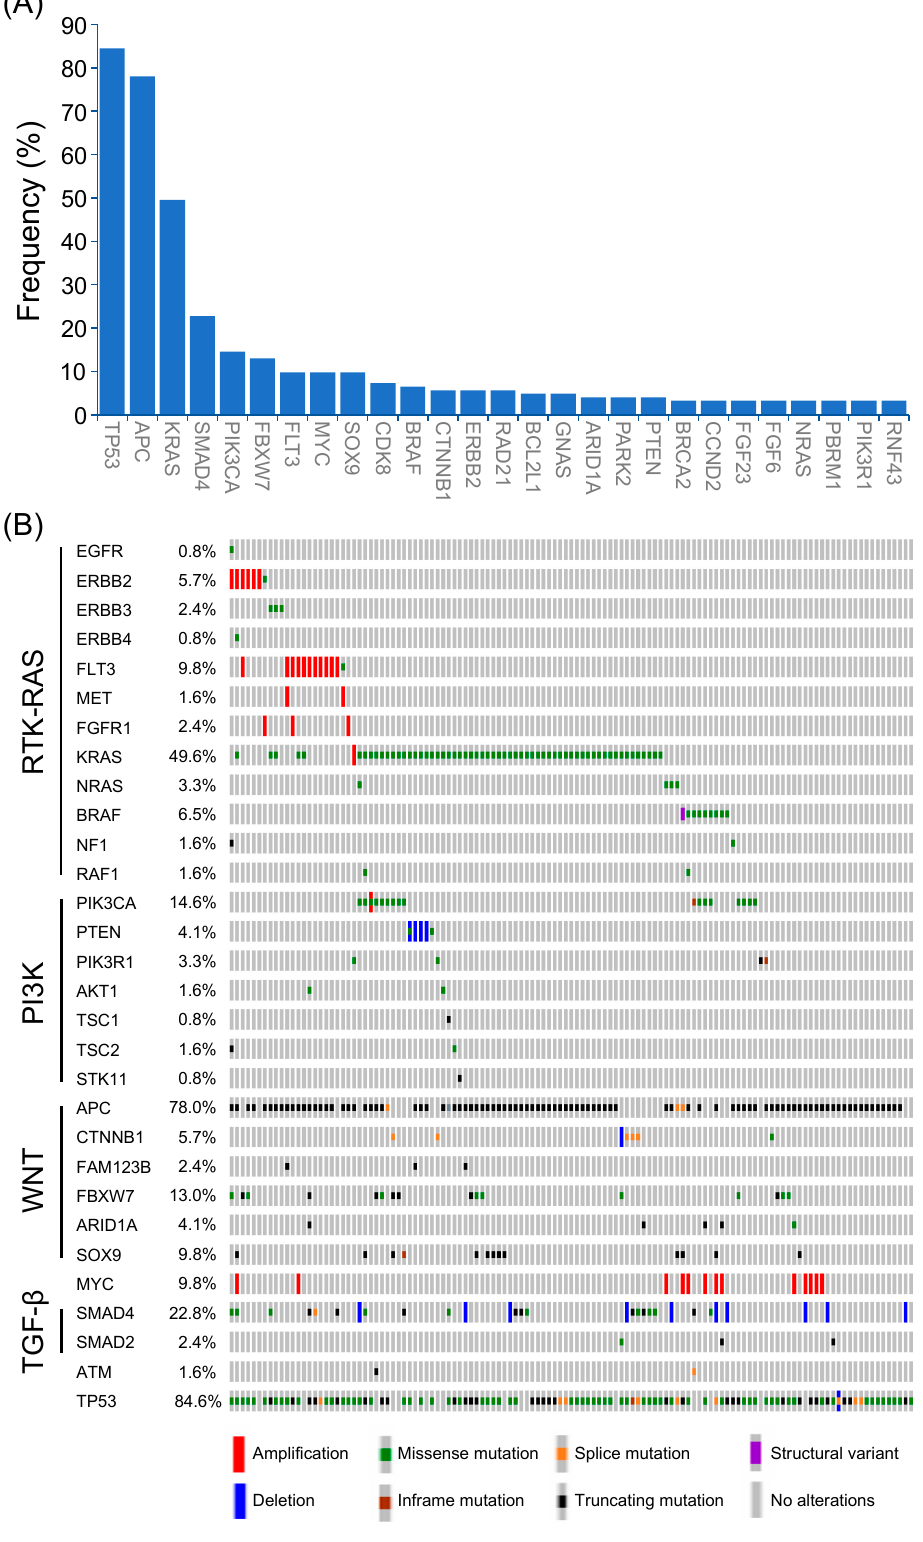
Figure 2. Genetic alterations of Taiwanese patients with non-MSI-H mCRC. ( A ) Frequencies of genetic alterations (>3%) were identified in non-MSI-H mCRC. ( B ) The frequencies, types, and co-occurrences of mutated genes in major oncogenic pathways.